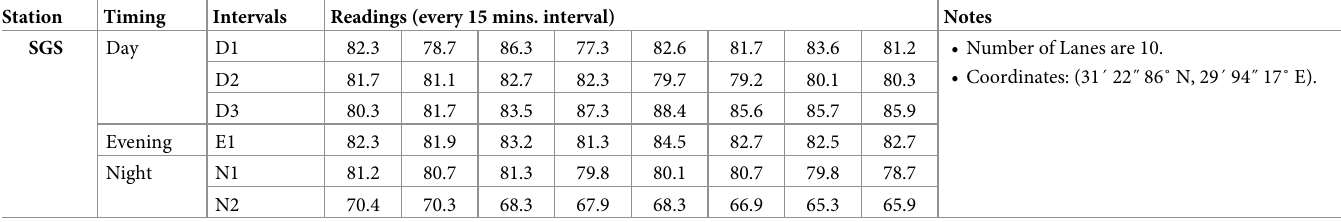
Table 8. The data sheet for Sidi Gaber Station (SGS) showing the noise level readings that were taken at the station on the selected intervals of the working day. Station Timing Intervals Readings (every 15 mins. interval) SGS